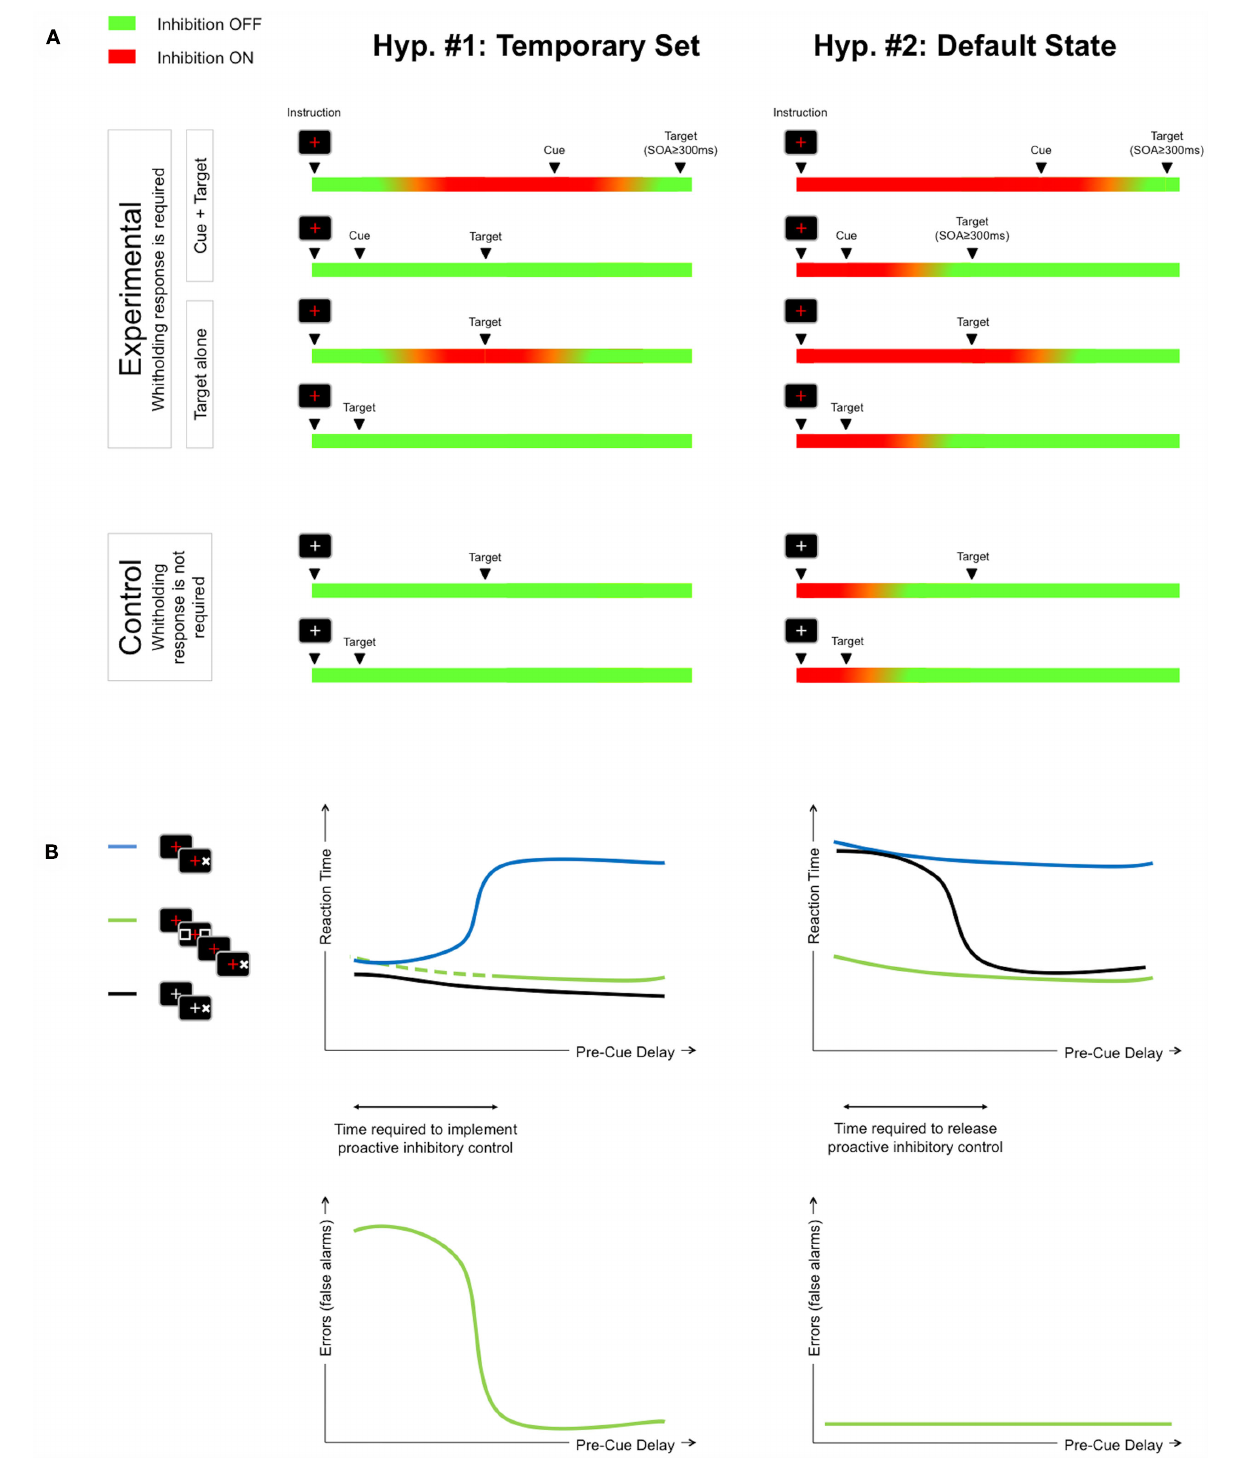
experimental condition. (B) Predictions regarding the evolution of both false alarms rate and RT according to pre-stimulus delay are presented (blue line: red_cross_no_cue; green line: red_cross_long_CTOA; black line: white_cross_no_cue). See text for details (see “Rationale”).